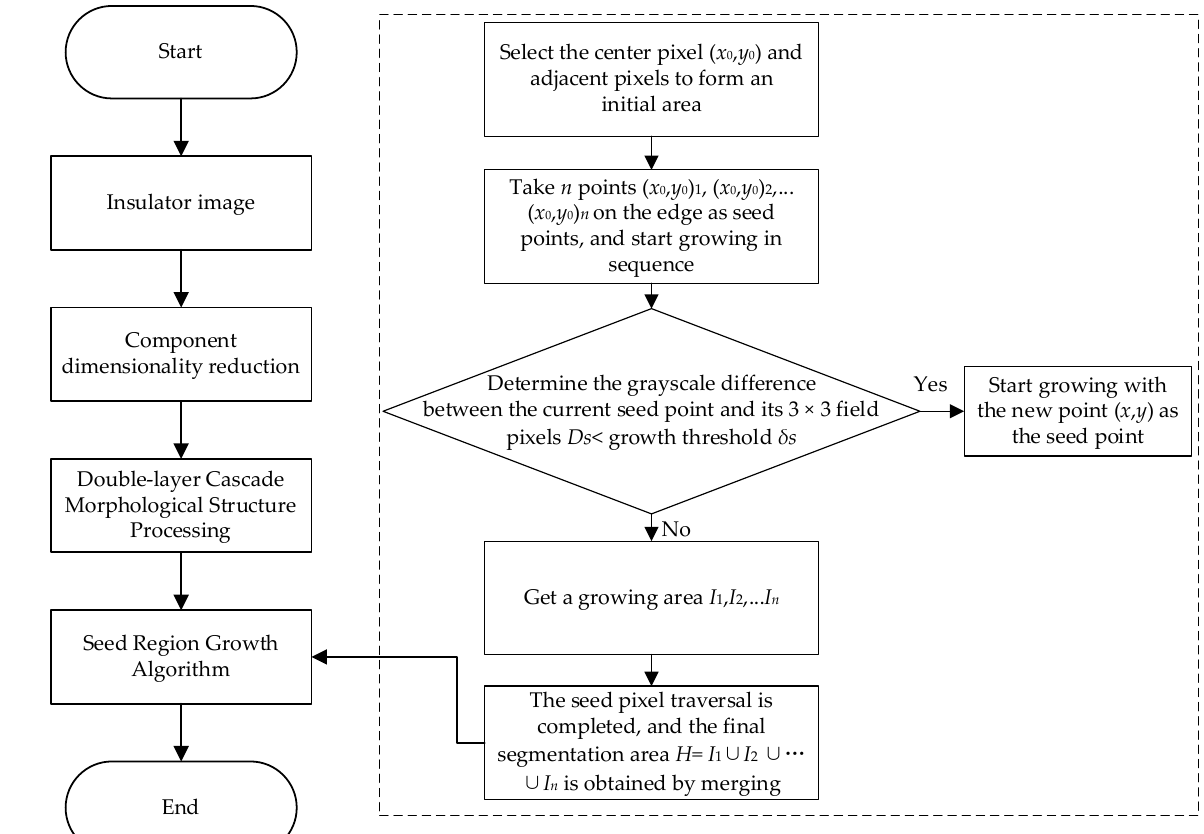
Figure 4. Flow chart of seed region segmentation based on morphological improvement.